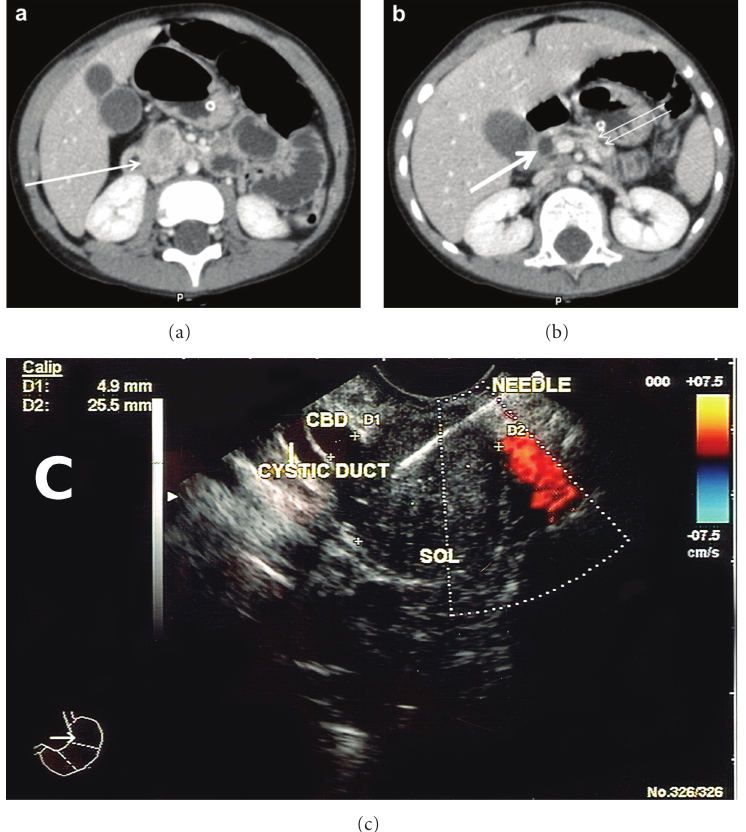
Figure 1: (a) CT Scan of Abdomen: Mass (Arrow) in head of pancreas. (b) CT Scan of Abdomen: Dilated Common (large arrow) and Pancreatic (Double arrow) ducts. (c) Endoscopic ultrasound image of lesion in head of pancreas.